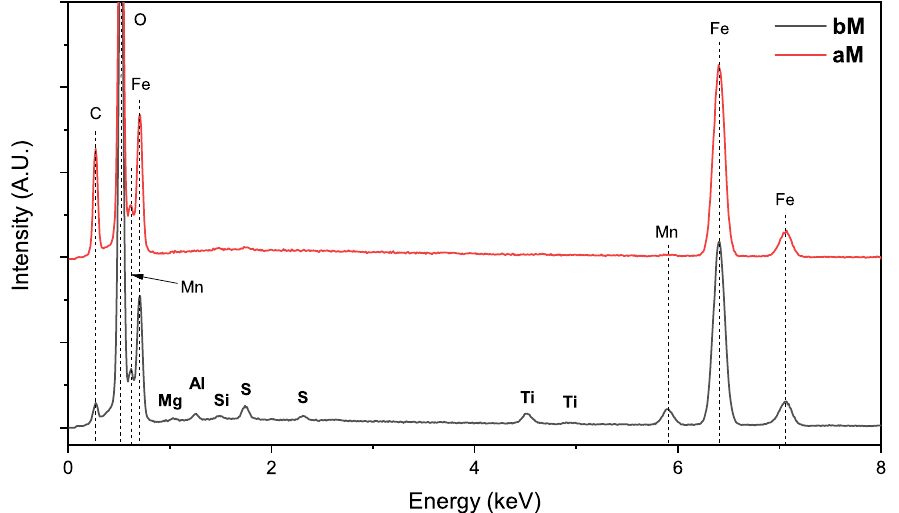
Figure 5. Chemical elemental analysis of bM and aM magnetite fillers. On the EDS spectrum of bM magnetite other elements are detected besides the oxygen and iron. The carbon peak present in both spectra comes from the material of the SEM sample